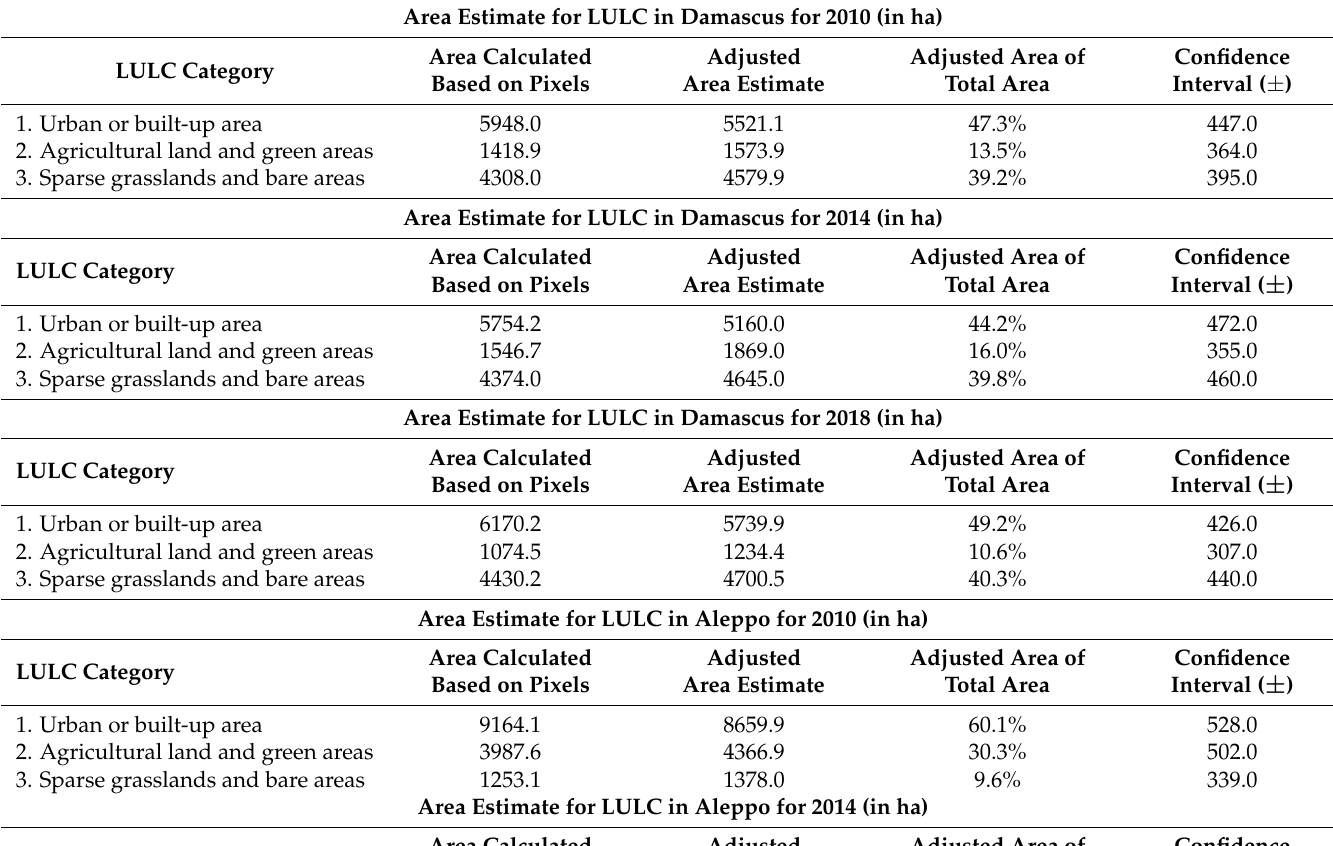
Table 5. Area estimates in hectare (ha) and percentage share (%) of each LULC category between 2010 and 2018 in Damascus and Aleppo after computing adjusted area